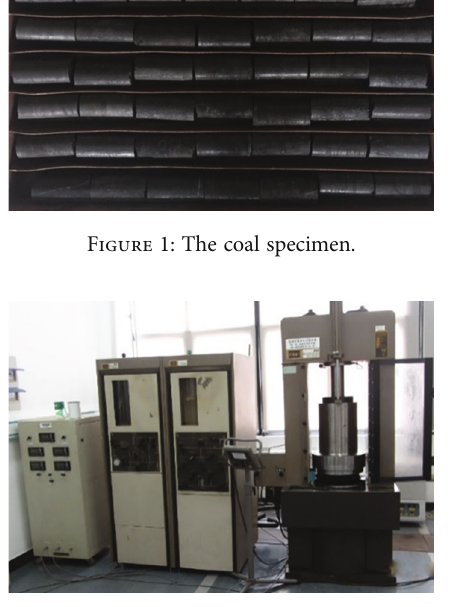
Figure 2: The 815.02 electro-hydraulic servo-controlled rock mechanics testing